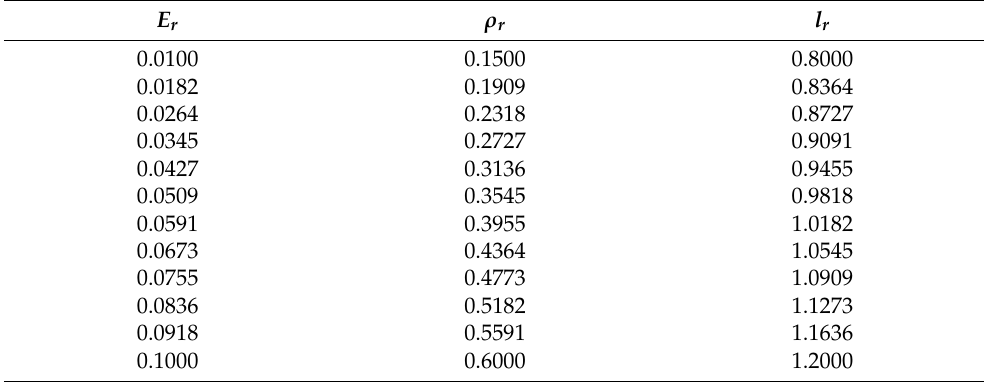
Table 2. The selected values of material parameters to compose the